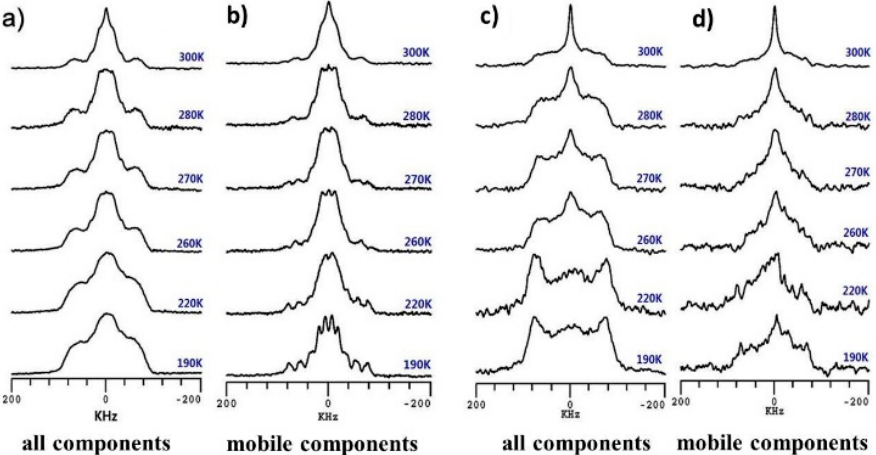
Figure 4. VT 2 H spectra obtained from: ( a , c ) quadrupolar echo experiments to obtain signals of all components; and ( b , d ) saturation recovery quadrupolar echo experiments to obtain signals of mobile components for CTS-A ( a , b ) and CTS-N ( c , d ), respectively.